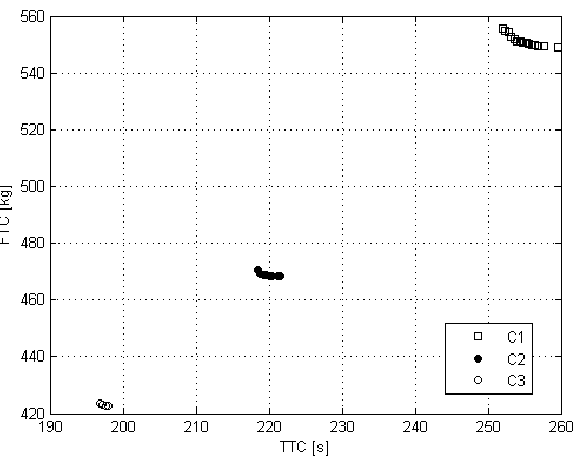
Figure 12. Case A; comparison of fronts of non-dominated solutions obtained for Configurations C1, C2 and C3.